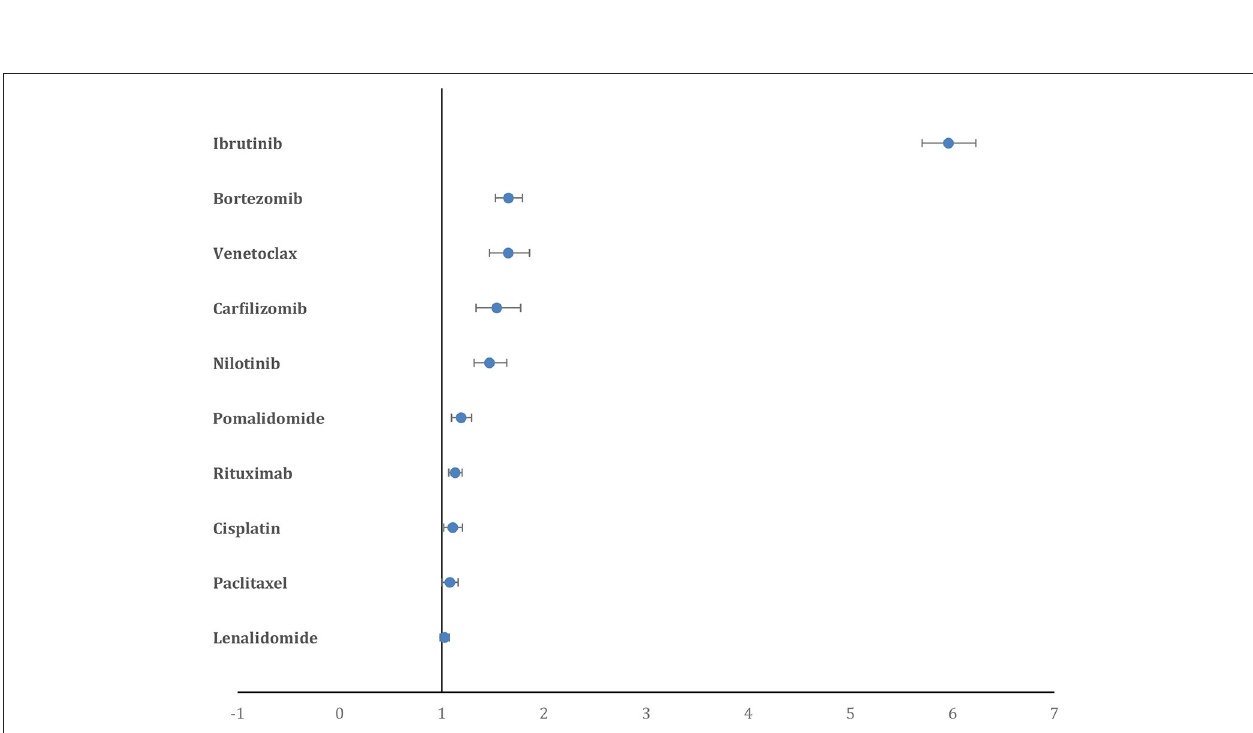
FIGURE 3 | Forest plot showing the PRR of AF for the top 10 drugs. Ibrutinib has a significantly higher PRR compared to all other drugs.